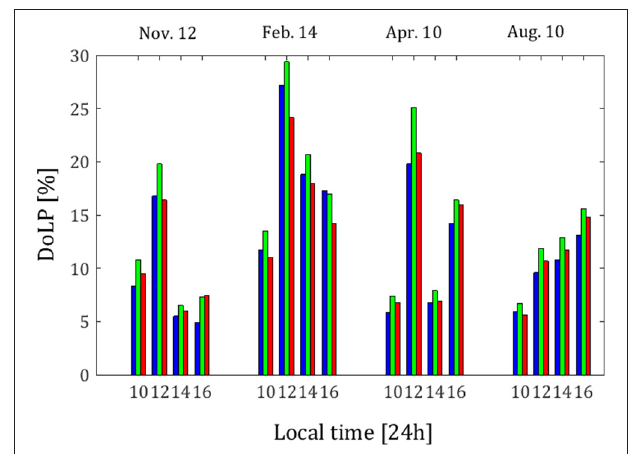
FIGURE 4 | DoLP as obtained from the spectrophotometer method on November 12th 2015, February 14th, 2016, April 10th, 2016, and August 10th, 2016. The dates and time of day of each measurement are indicated along the horizontal axis. From each measurement, weighted values from blue, green and red wavebands are presented (each in its own